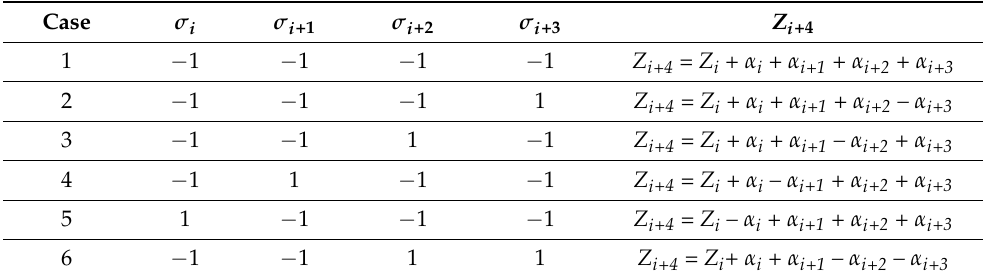
Table 3 lists recurrent equations of Z i +4 when { σ i , σ i +1 , σ i +2 , σ i +3 } ranges from { − 1, − 1, − 1, − 1} to {1, 1, 1, 1}. Table 3. Recurrent equations of Z i +4 in